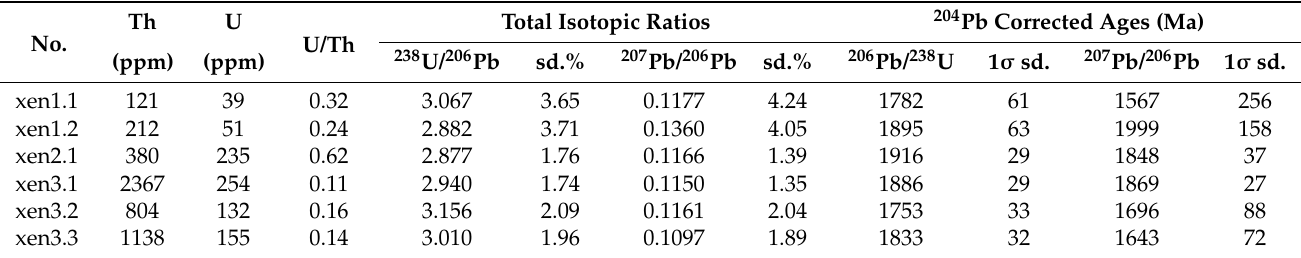
Table 4. Xenotime U–Pb isotopic data and corrected ages.